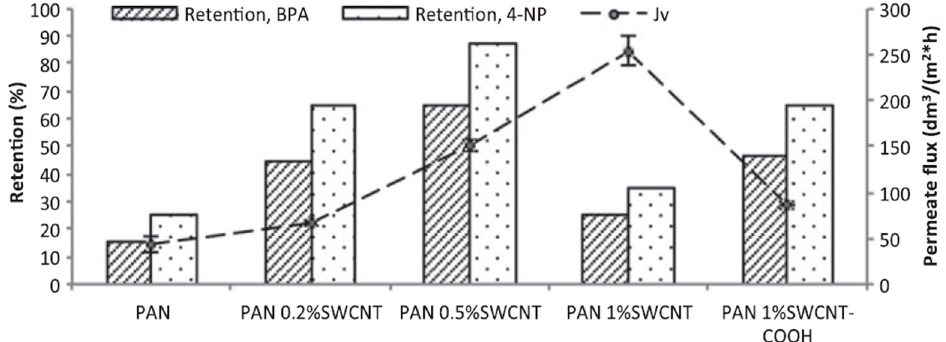
Figure 12. Effect of SWNT loading on wastewater flux (at 0.5 bar) and the removal of bisphenol A (BPA) and 4-nonylphenol (4-NP) by composite polyacrylonitrile (PAN)/SWNT membranes. Reproduced with permission from Reference [99]. Copyright Taylor and Francis, 2016.